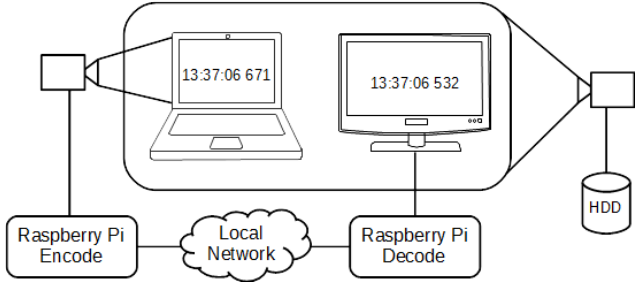
Figure 5. Measurement setup with local